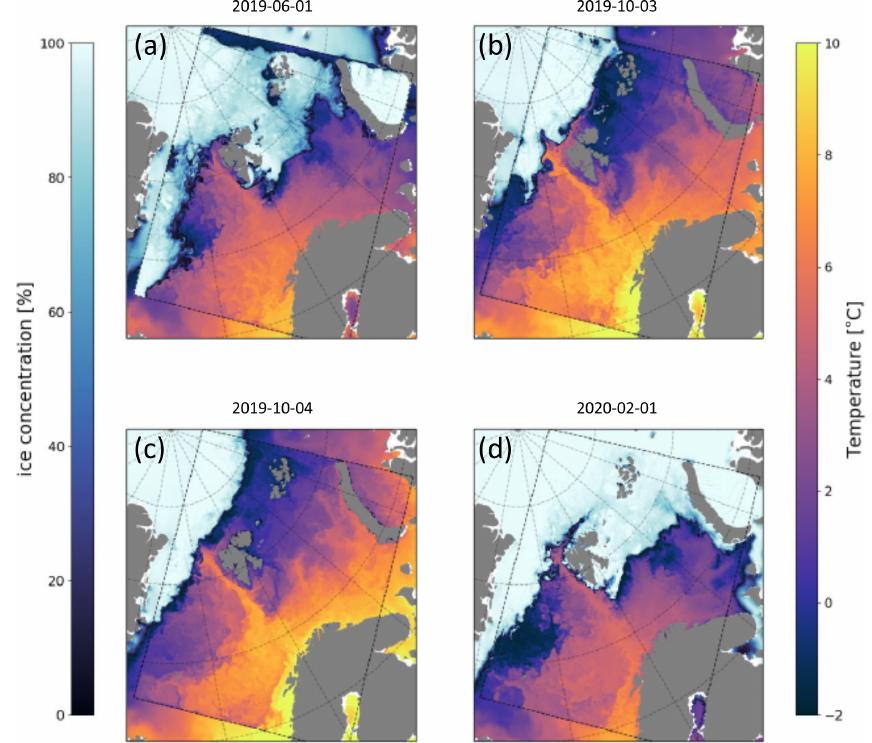
Figure 3. Operational simulations with the Barents-2.5km model, plotted inside the TOPAZ4 model. These plots are taken directly from the operational model at MET and illustrate the effects of time-varying boundary conditions in the operational model. Sea ice concentration and surface water temperature fields (in the open water areas) are shown for three different dates at 00:00UTC. Panel (a) are a few months before new BCs, (b) the day before new BCs, (c) the day of new BCs and (d) a few months after new